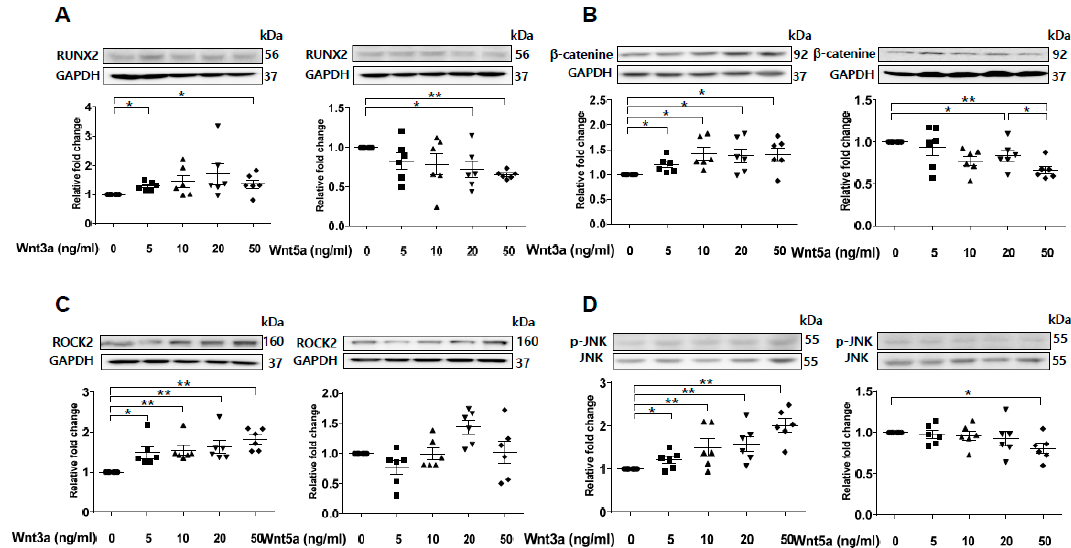
Figure 5. Wnt3a-mediated noncanonical ROCK / JNK signaling is involved in the osteoblastic differentiation of vascular smooth muscle cells (VSMCs). VSMCs were treated with Wnt3a and Wnt5a in a dose-dependent manner. The protein levels of RUNX2, β -catenin, ROCK2, and p-JNK / JNK were determined using Western blotting. Six replicates per condition were performed. ( A ) Wnt3a induced an increase in RUNX2 expression, whereas high-dose Wnt5a (50 ng / mL) induced a decrease in RUNX2 expression in VSMCs; ( B ) Wnt3a upregulated β -catenin protein levels, and Wnt5a dose-dependently downregulated β -catenin protein levels; ( C ) Wnt3a, but not Wnt5a, induced an increase in ROCK2 expression; ( D ) Wnt3a induced JNK phosphorylation, whereas Wnt5a inhibited JNK phosphorylation. Data are expressed as means ± standard errors of the means from six independent experiments. * p < 0.05, ** p < 0.01.